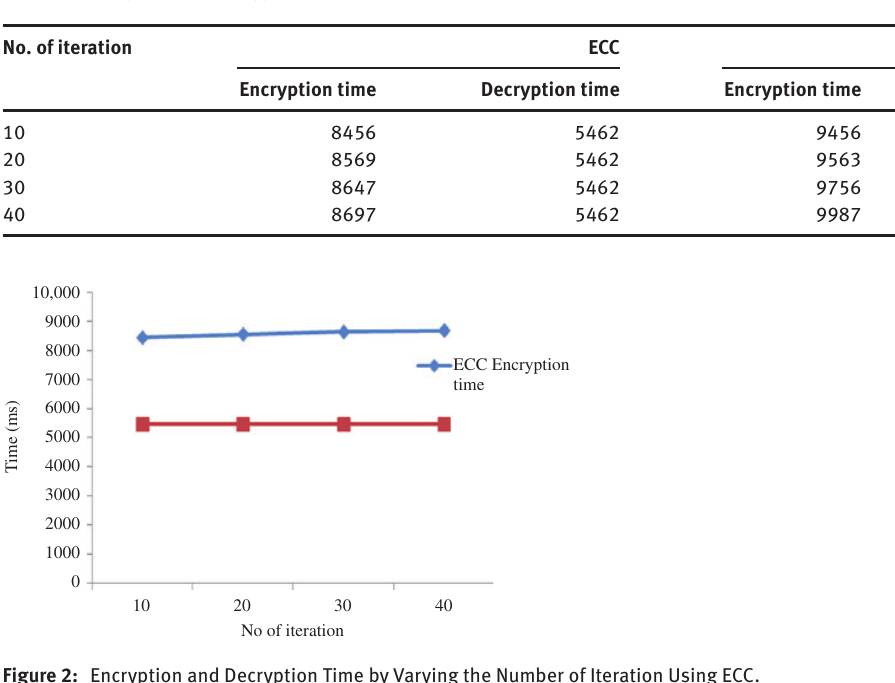
Figure 2: Encryption and Decryption Time by Varying the Number of Iteration Using ECC.